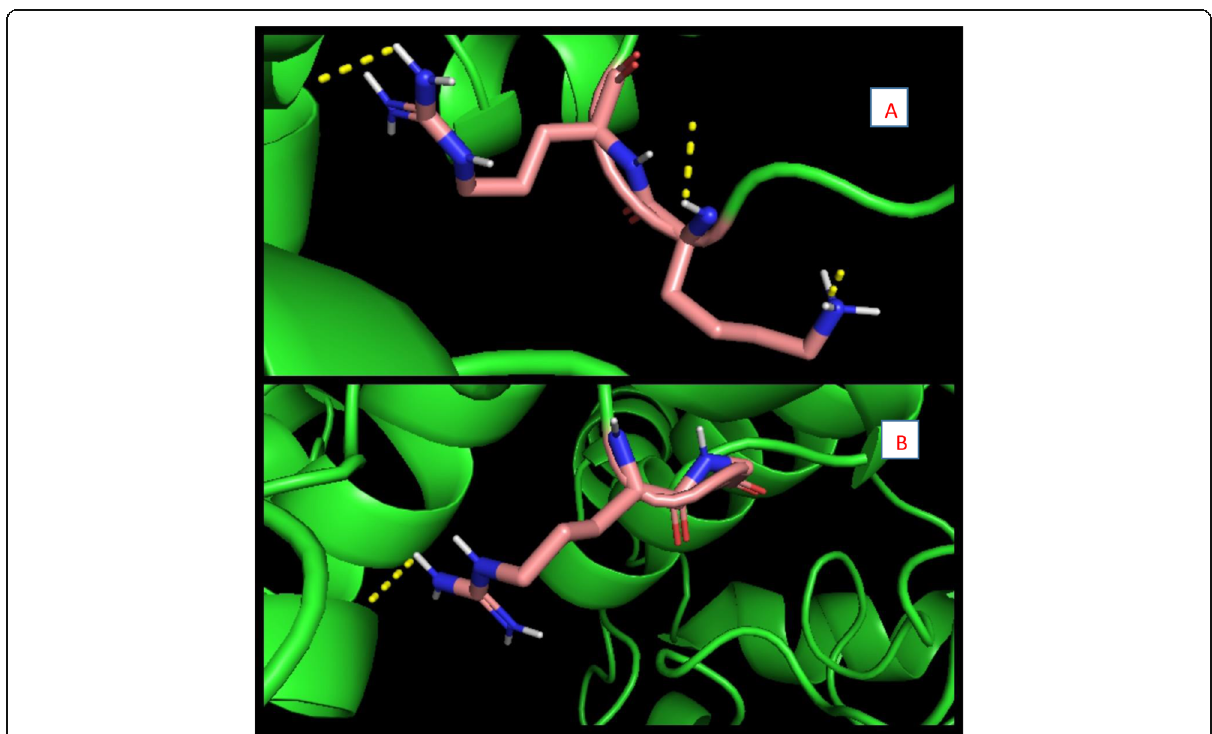
Fig. 3 A Determination of Hydrogen bonds over 2.5 Å for the mutated residues, using Pymol. Mutated residues shown as sticks (atoms: nitrogen- blue, carbon-pink, hydrogen-white), N protein in green and hydrogen bonding as yellow dots. B Determination of hydrogen bonds over a 2.5 Å range for wild type residues. Original wild type residues shown as sticks (atoms: nitrogen-blue, carbon-pink, hydrogen-white, oxygen-red), N protein in green and hydrogen bonding as yellow